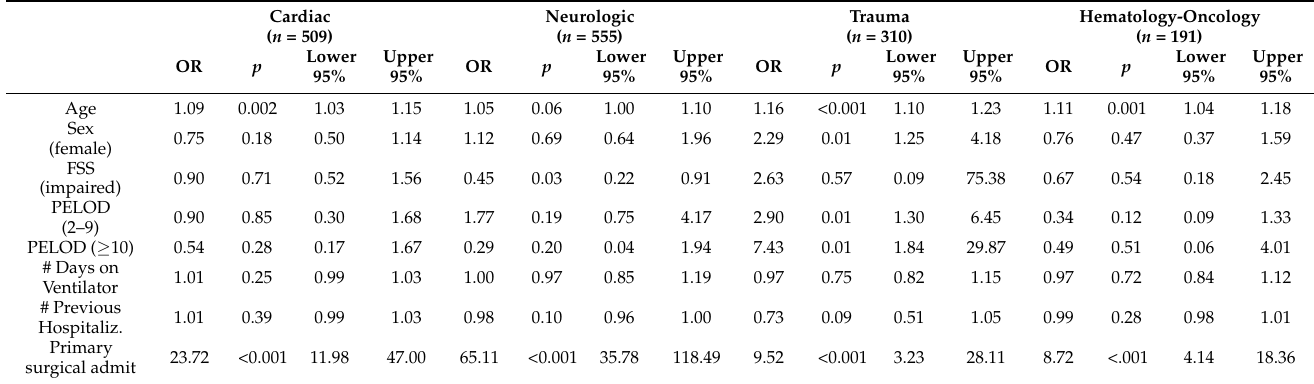
Table 5. Binary logistic regression models estimating effects of clinical and demographic factors on receipt of opioid at PICU discharge by individual diagnostic group (cardiac, neurologic, trauma,